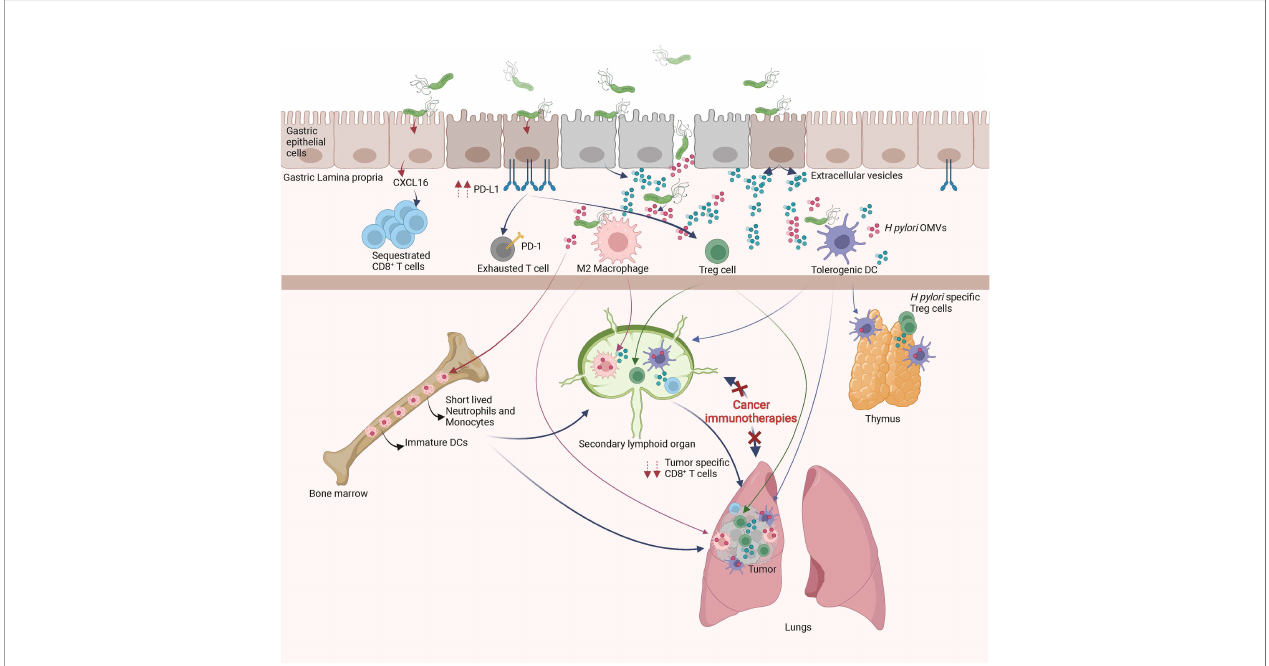
FIGURE 2 | Local and remote effects of H pylori infection on host immune functions. In the gastric mucosa, H pylori promotes the differentiation of tolerogenic DCs, M2 macrophages, Treg cells, inhibits Th1/Th17 responses and/or sequesters CD8 + T cells. The systemic diffusion/migration of extracellular vesicles, outer membrane vesicles (OMVs), Treg cells, tolerogenic DCs and M2 macrophages modulates the function of primary and secondary lymphoid organs, leading to a decrease in tumor speci fi c immune responses triggered by cancer